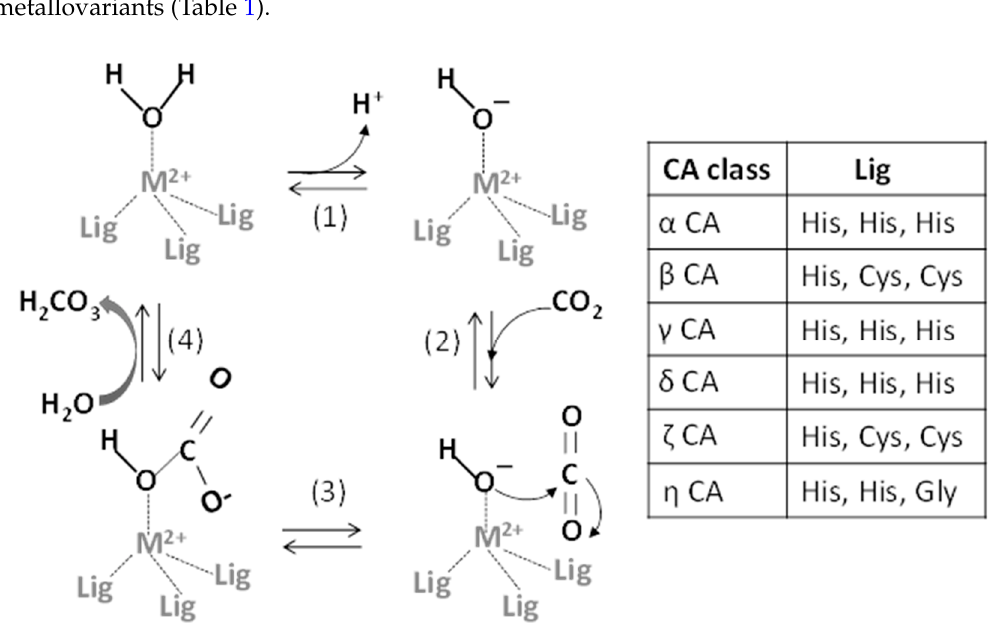
Figure 1. The reversible hydration of carbon dioxide to bicarbonate catalyzed by CAs by means of a metal (M)-hydroxide mechanism. Modified from Berg [17]. ( 1 ) The release of a proton from the zinc-bound water generates the zinc-bound OH − ; ( 2 ) A CO 2 molecule binds to the active site and is positioned for optimal interaction with the zinc-bound OH − ; ( 3 ) The hydroxide ion attacks the carbonyl of CO 2 , producing HCO 3 − ; ( 4 ) The release of HCO 3 − regenerates the enzyme.